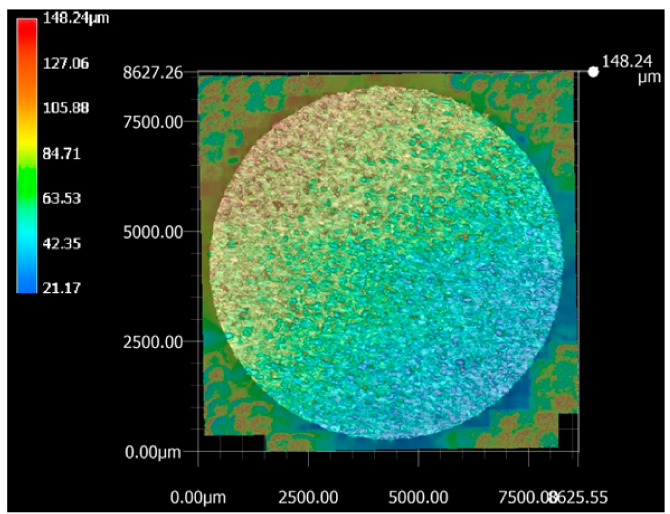
Figure 4. Machined surface representing surface roughness (SR) values for superelastic nitinol